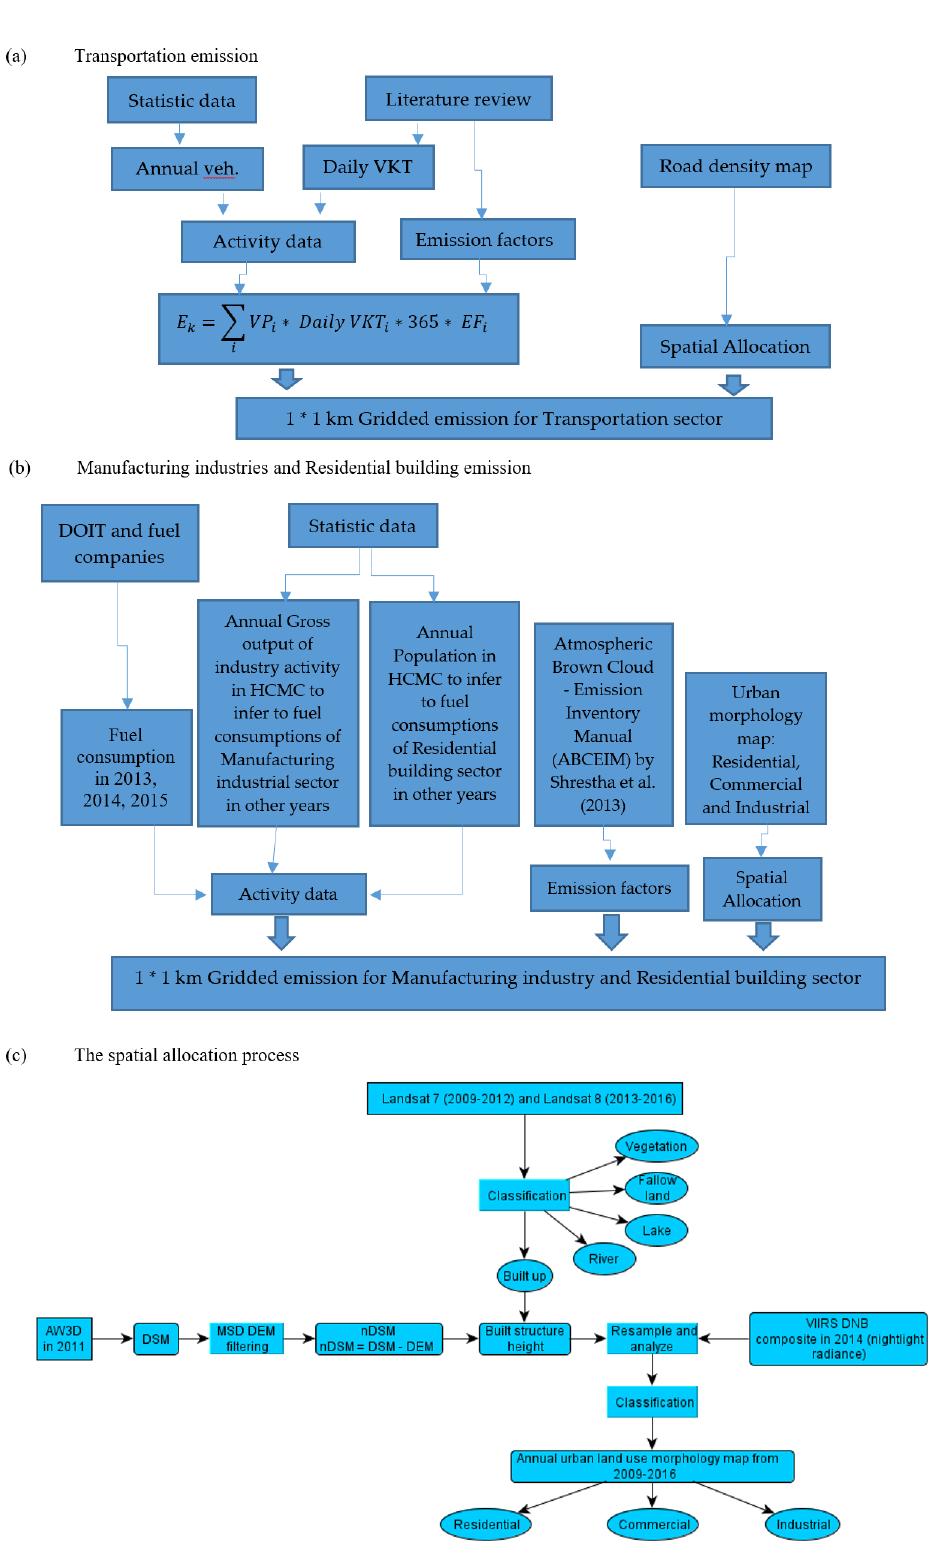
Figure 2. Schematic flow diagrams showing estimation of emissions from (a) transportation sources, (b) manufacturing industry sources and residential building sources as well as (c) the spatial allocation